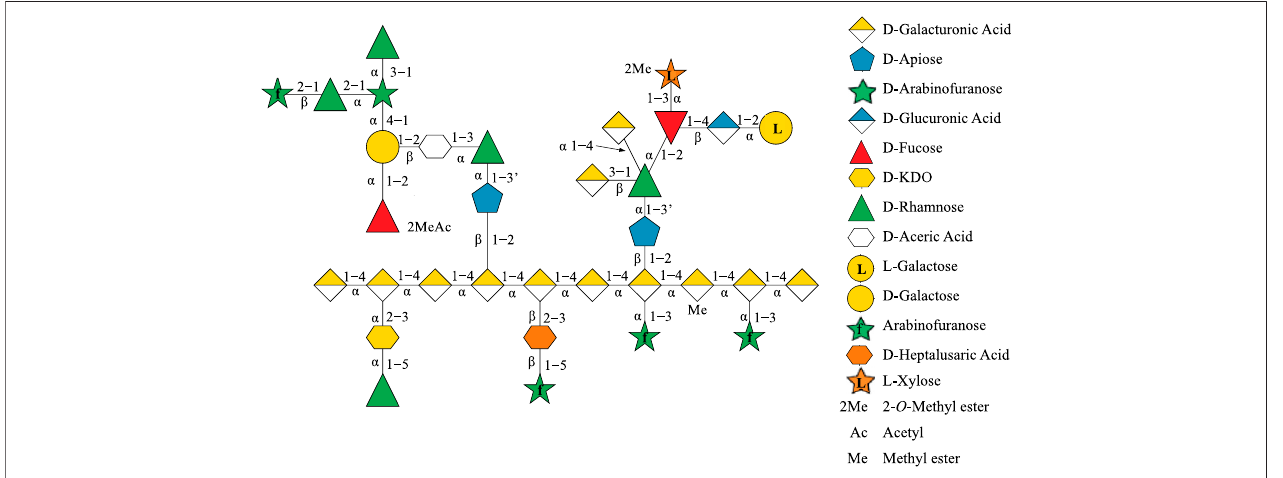
FIGURE 1 | Topological structure of Rhamnogalacturonan II (RG-II) depicted as linked sugar molecules, with apiose as a blue pentagon